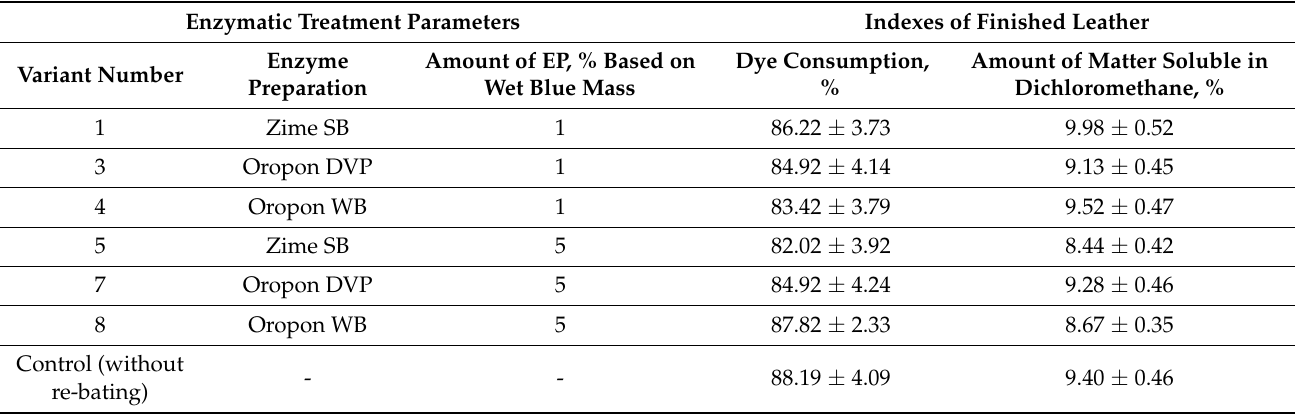
Table 6. Dye consumption and amount of matter soluble in dichloromethane (%) in finished